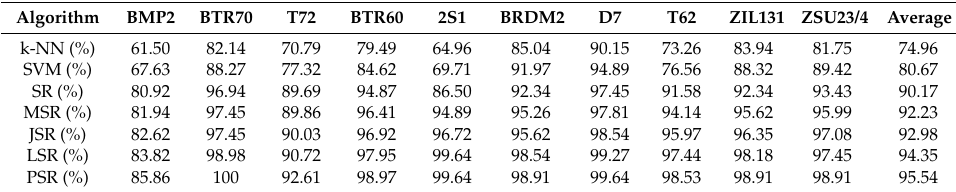
Table 3. The recognition results for 10-type